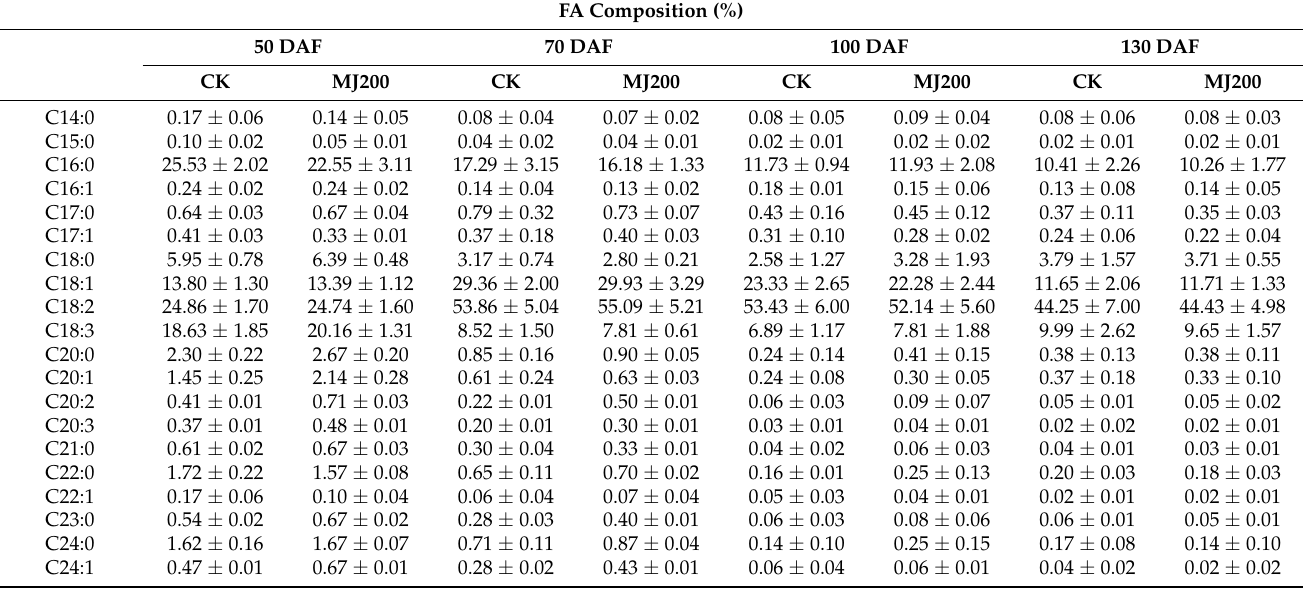
Table 1. Effects of MJ200 on FA compositions during seed